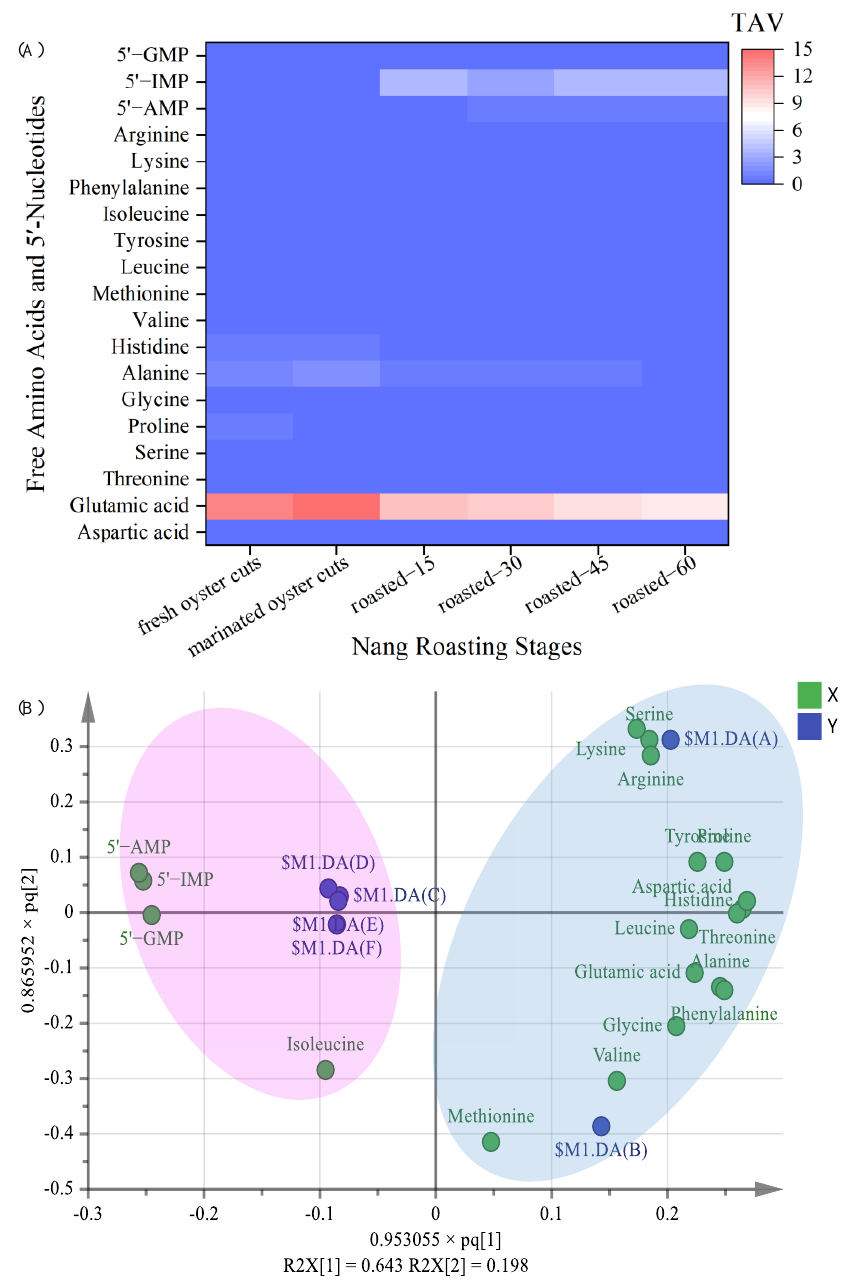
Figure 2. Taste activity value (TAV) of nonvolatile compounds ( A ) and orthogonal partial least square discriminant analysis (OPLS-DA) based on nonvolatile compounds in Nang roasted oyster cuts ( B ). $M1.DA(A), fresh oyster cuts; $M1.DA(B), marinated oyster cuts; $M1.DA(C), $M1.DA(D), $M1.DA(E) and $M1.DA(F) means roasted-15, roasted-30, roasted-45 and roasted-60, respectively.